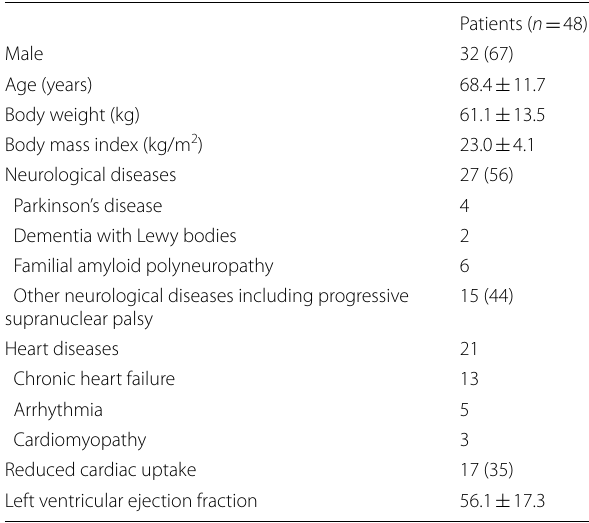
standard deviation unless otherwise ±